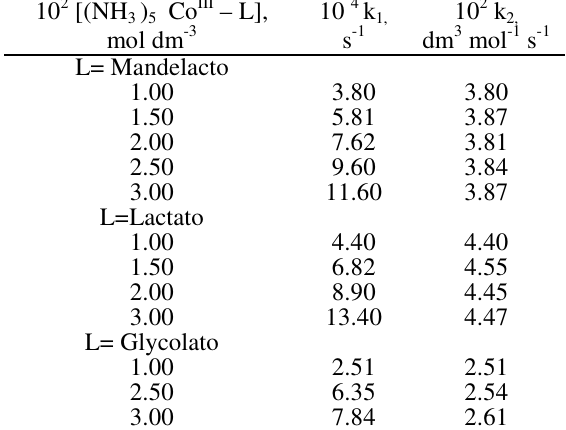
Table 4. First order values of the concentration of cobalt(III) bound α -hydroxy acids in NaLS. [H O ] = 2.00 x 10 -3 mol dm -3 , [H 2 2 Temperature = 35 ± 0.2 0 C.